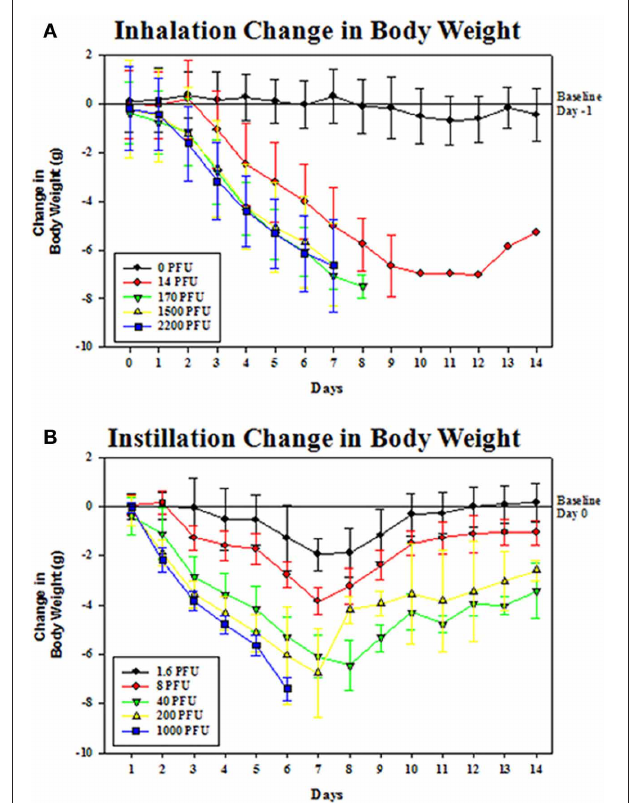
PR8 by (A) inhalation, and (B) instillation. Mice in each group ( n = 8) were weighed individually on each day after challenge. Each graph shows the group mean change in weight relative to the Day 0 (inhalation) and Day 1 (instillation) baseline body weights. Error bars are ± standard deviation of the mean.